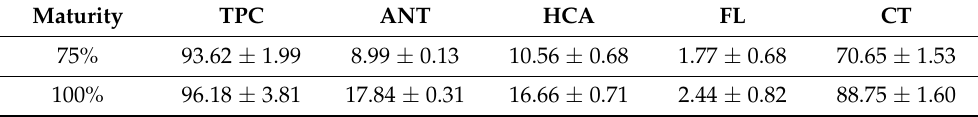
Table 1. Average values for analytical parameters in untreated samples (control). Maturity